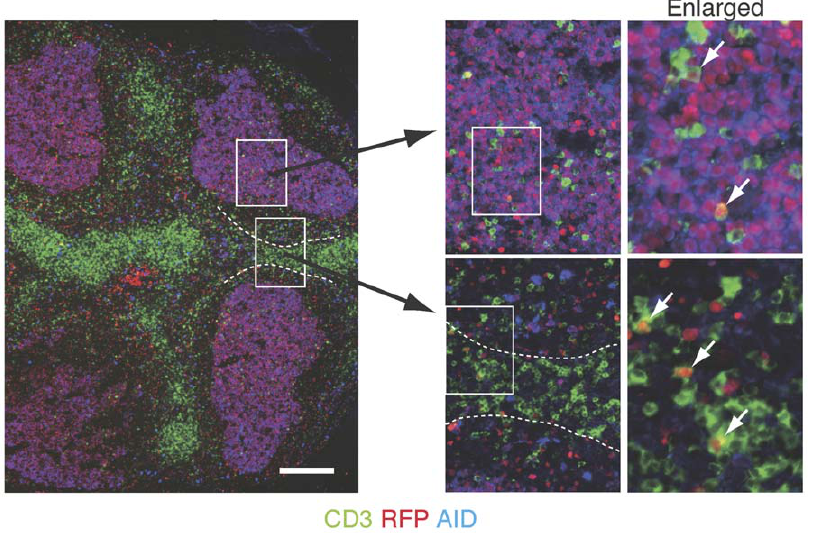
Figure 5. The localization of exAID CD3 + cells in Peyer’s patches. Left panel: an image of a Peyer’s patch, taken with a low power field, stained with CD3 (green), AID (blue), and RFP (red). The section was cut at the position where the germinal center was dense. The dotted line indicates part of a T-B border. Bar represents 200 m m. Right panels: enlarged view of the area indicated in the left panel. White arrows indicate CD3 + RFP + double-positive cells.